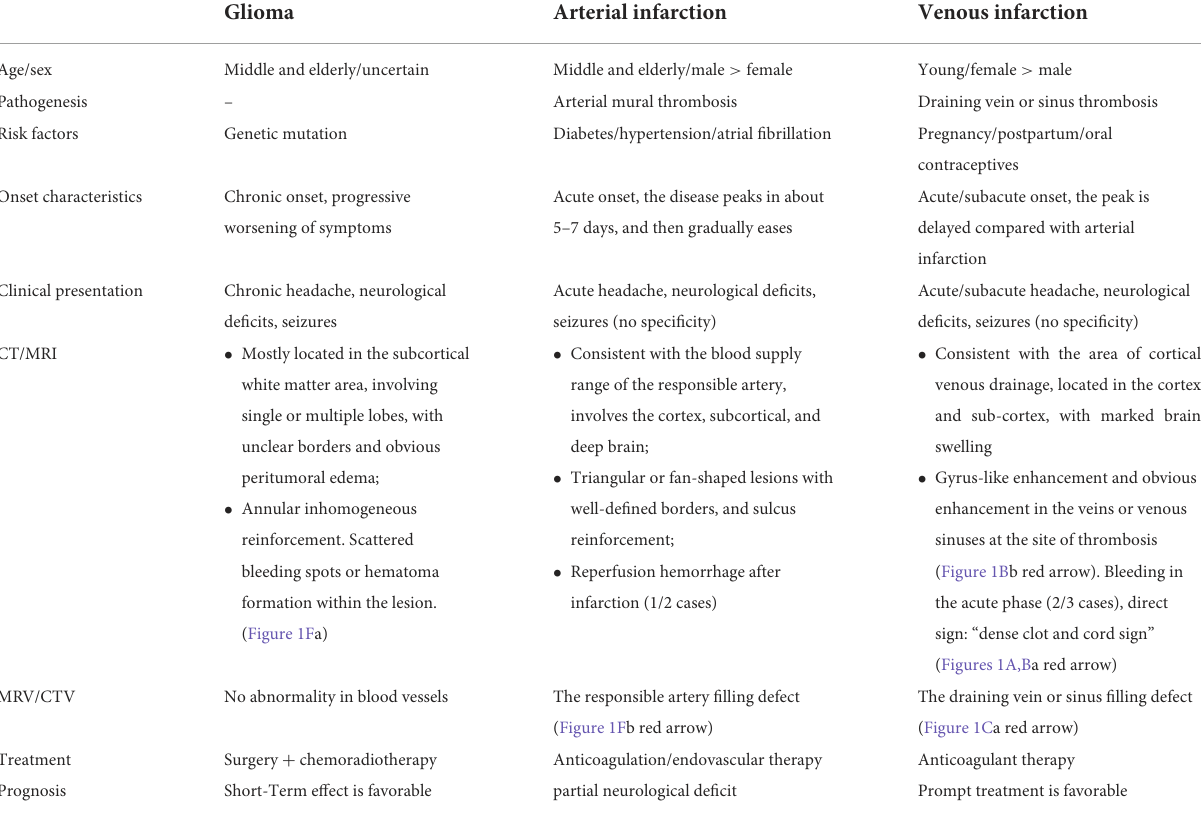
TABLE 1 The detailed identification of glioma, arterial cerebral infarction, and cortical venous